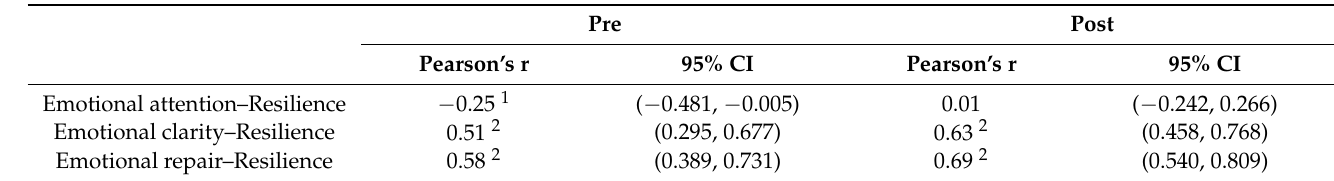
Table 2. Emotional intelligence and resilience. Pearson correlations and descriptive plots.